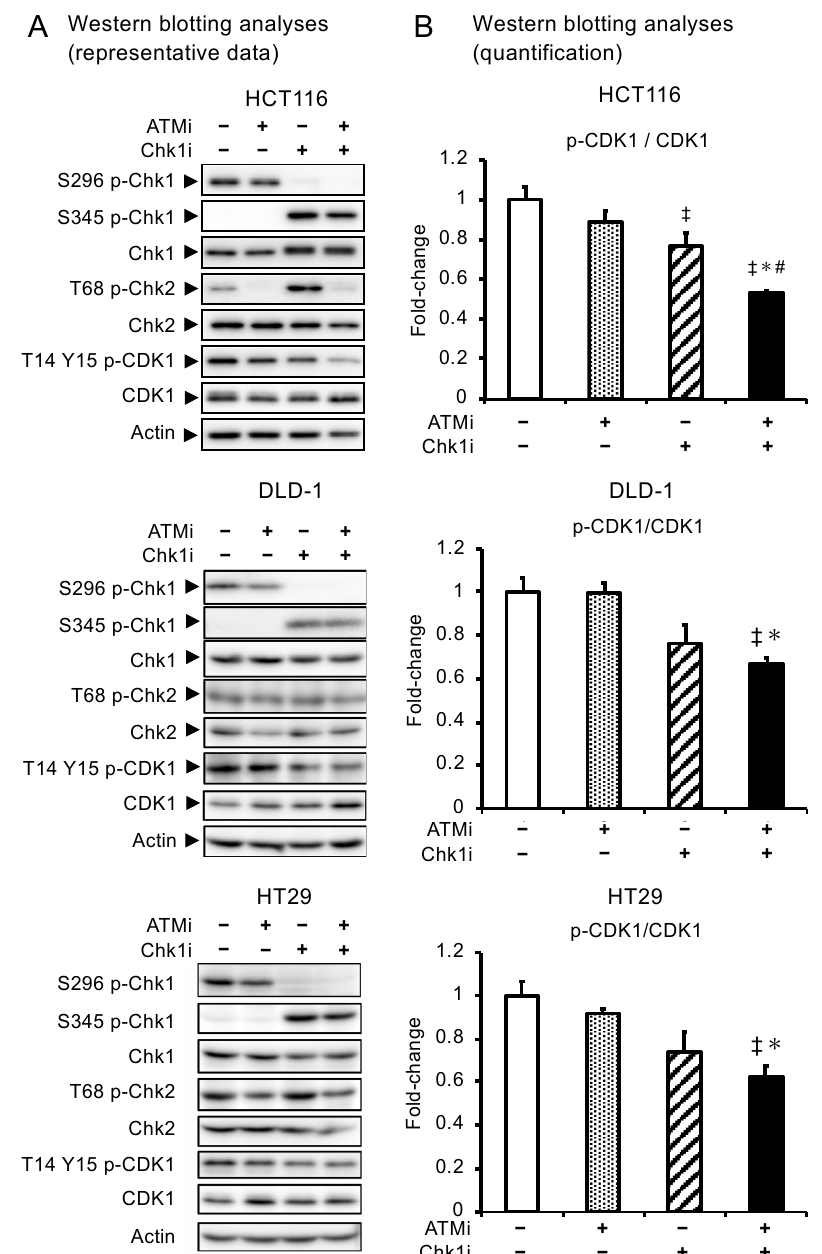
Figure 2. Phosphorylation of Chk1, Chk2, and CDK1 during drug treatment. ( A ) Western blotting analysis of Chk1, phospho-Chk1 (S296 and S345), Chk2, phospho-Chk2 (T68), CDK1, and phospho- CDK1 (T14 and T15) in HCT116, DLD-1, and HT29 cells treated with ATMi (10 μ M), Chk1i (0.03 μ M), or both drugs for 6 h. ( B ) Quantification of the amount of each protein as determined by Western blotting analysis in the three cancer cell lines. Protein levels were normalized to actin levels. Data are presented as mean ± SE ( n = 3; ‡ p < 0.05, vs. control; * p < 0.05, vs. ATMi group, # p < 0.05, vs. Chk1i group; Tukey’s multiple comparison test). Uncropped versions of the immunoblotting data are shown in Supplementary Figure S3A. Relative intensities of the bands in the immunoblot data are shown in Supplementary Figure S3B.